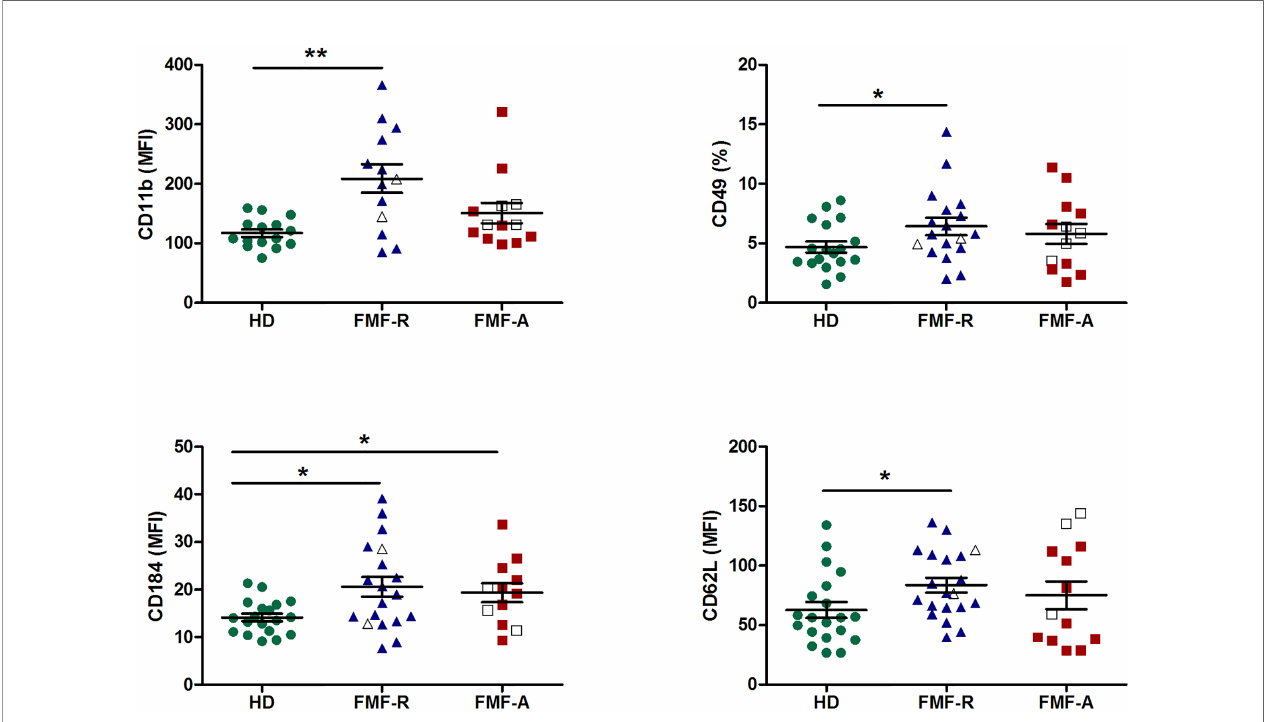
FIGURE 2 | Surface expression of CD11b, CD49d, CD184 (CXCR4), and CD62L on circulating PMNs from HD, FMF-R and FMF-A patients. * p < 0.05; ** p < 0.01.